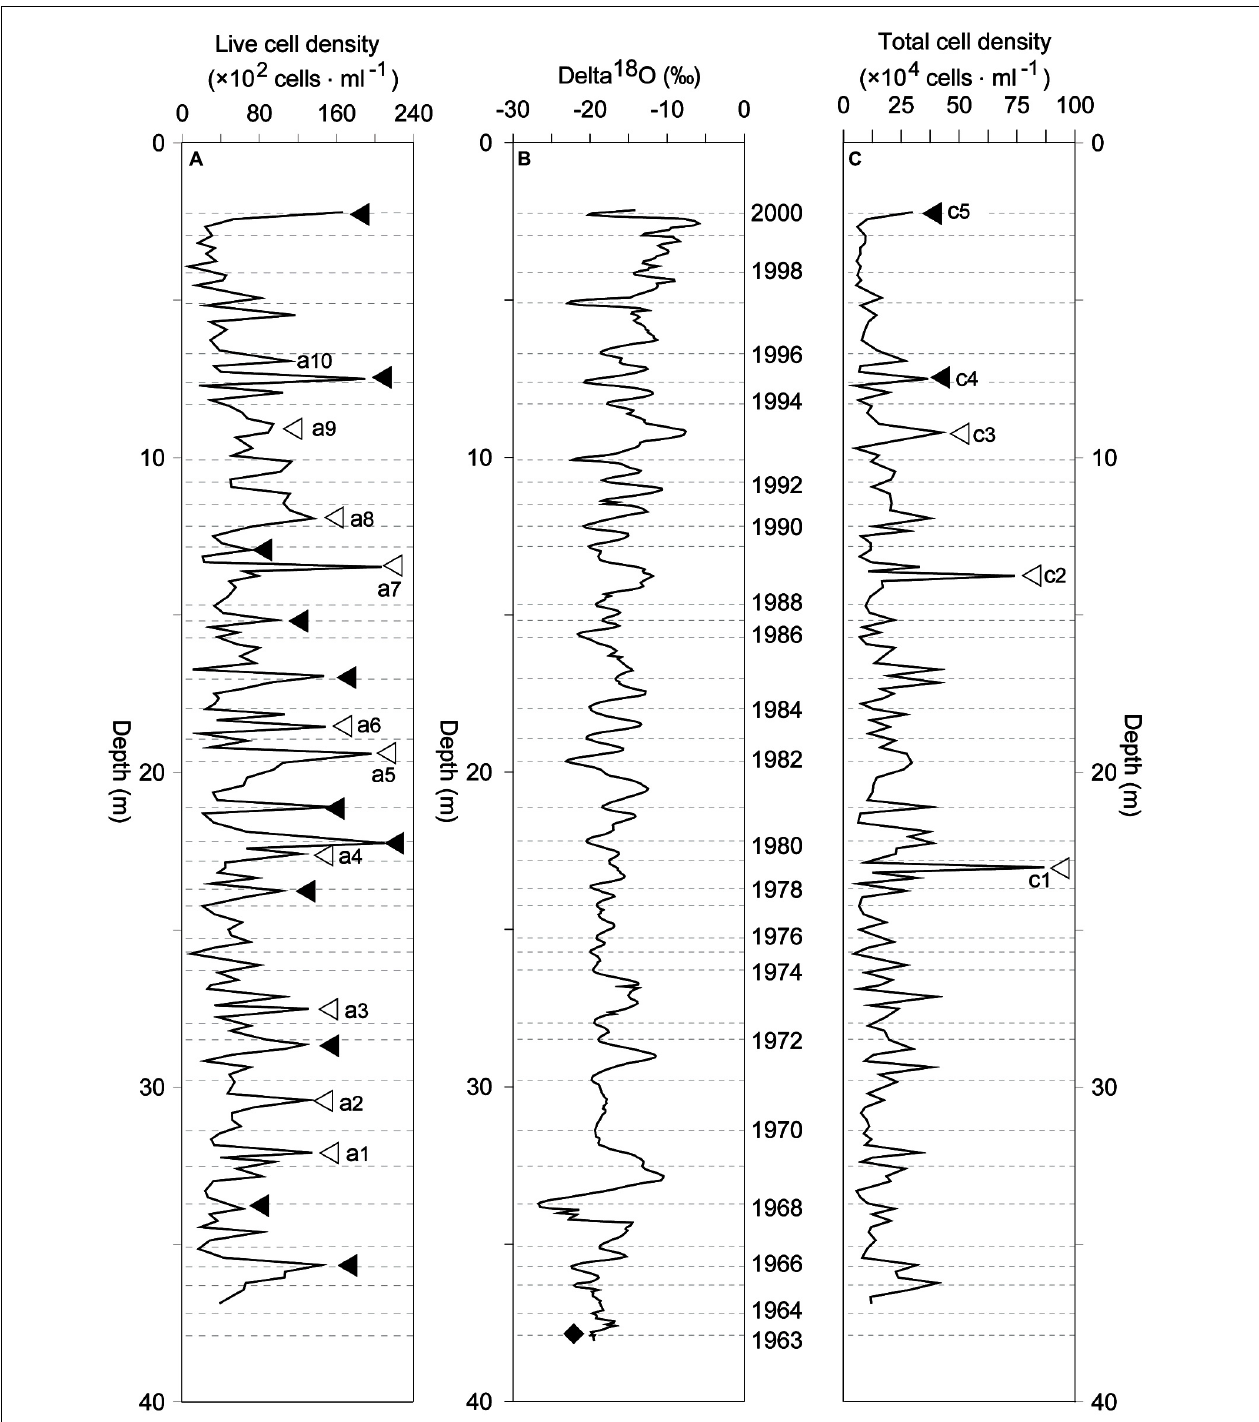
FIGURE 2 | Bacterial cell density and δ 18 O in the Muztagata ice core. The Muztagata ice core (37-m-long) was extracted at 7010 m ASL from the Muztagata Glacier in the summer of 2003. (A) Live cell density in the ice. (B) The δ 18 O value was measured by Finnegan MAT-252 mass-spectrometer (adapted from Tian et al., 2006). Ice core was annually dated by using seasonal δ 18 O variations and annual visible dust layers, and the peak of beta radioactivity by the nuclear weapon test in 1963 was identified at a depth of 37.89 m (Tian et al., 2006). (C) Total bacterial cell density estimated by using flow cytometer and cFDA/PI-stain, see the detailed in the “Study Area, Data Collection, and Methodology”). The annual ice layers ranged from 50 to 136 cm, and the years were indicated by the dash lines in the (A–C) . The data presented here were only for the ice core section in a depth range from 2.21 to 37 m since the annual layers become thinner below 35 m and the ice layer being near the bottom of the glacier (the depth of the glacier is 52.6 m, Tian et al., 2006).